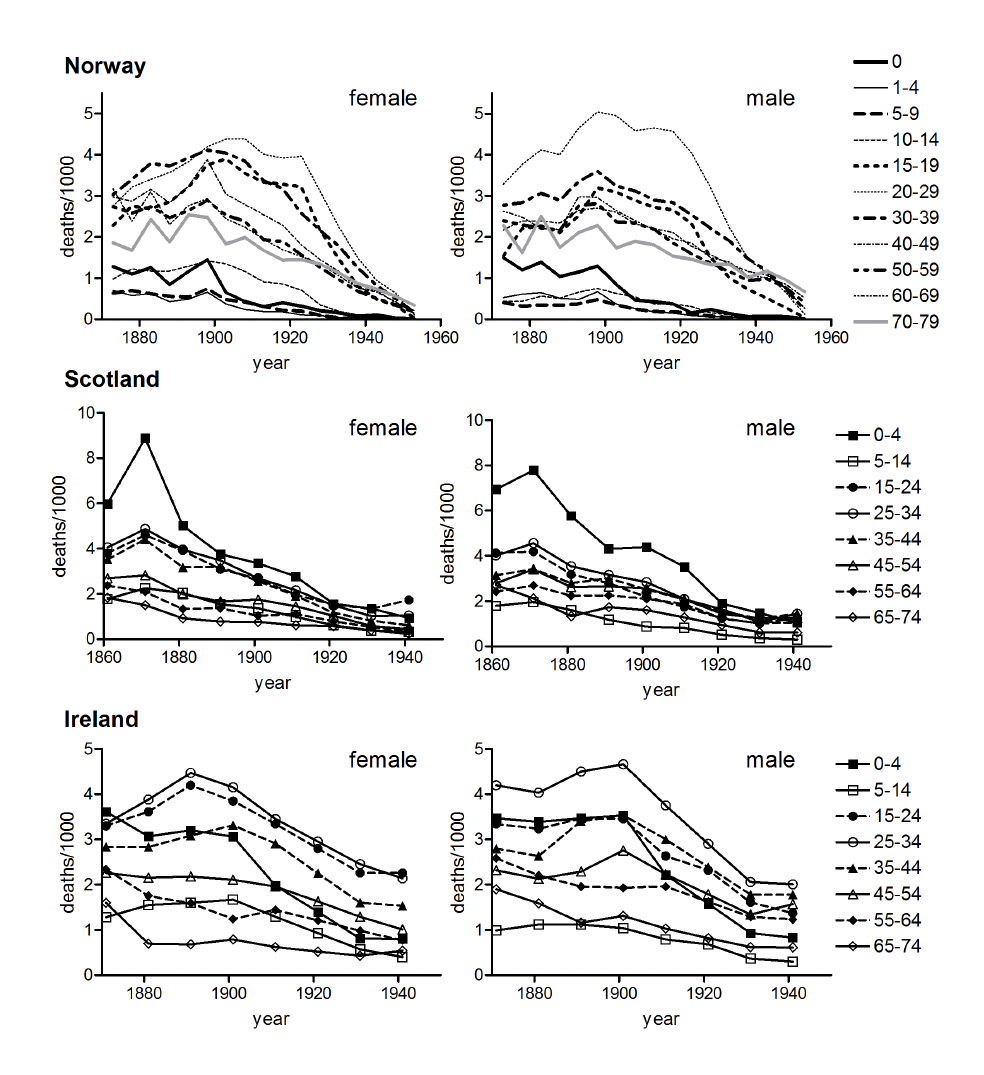
Figure 9. Age-specific tuberculosis mortality by period of death in populations with late declines. All tuberculosis (Ireland and Scotland), respiratory tuberculosis ages 0–14, all tuberculosis ages 15 +